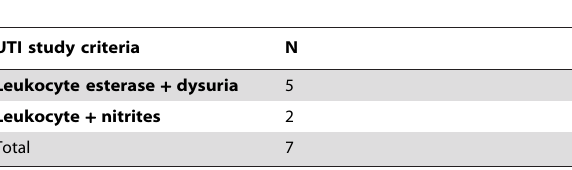
Table 4. Detailed analysis of seven women positive for UTI based on study criteria but not diagnosed on